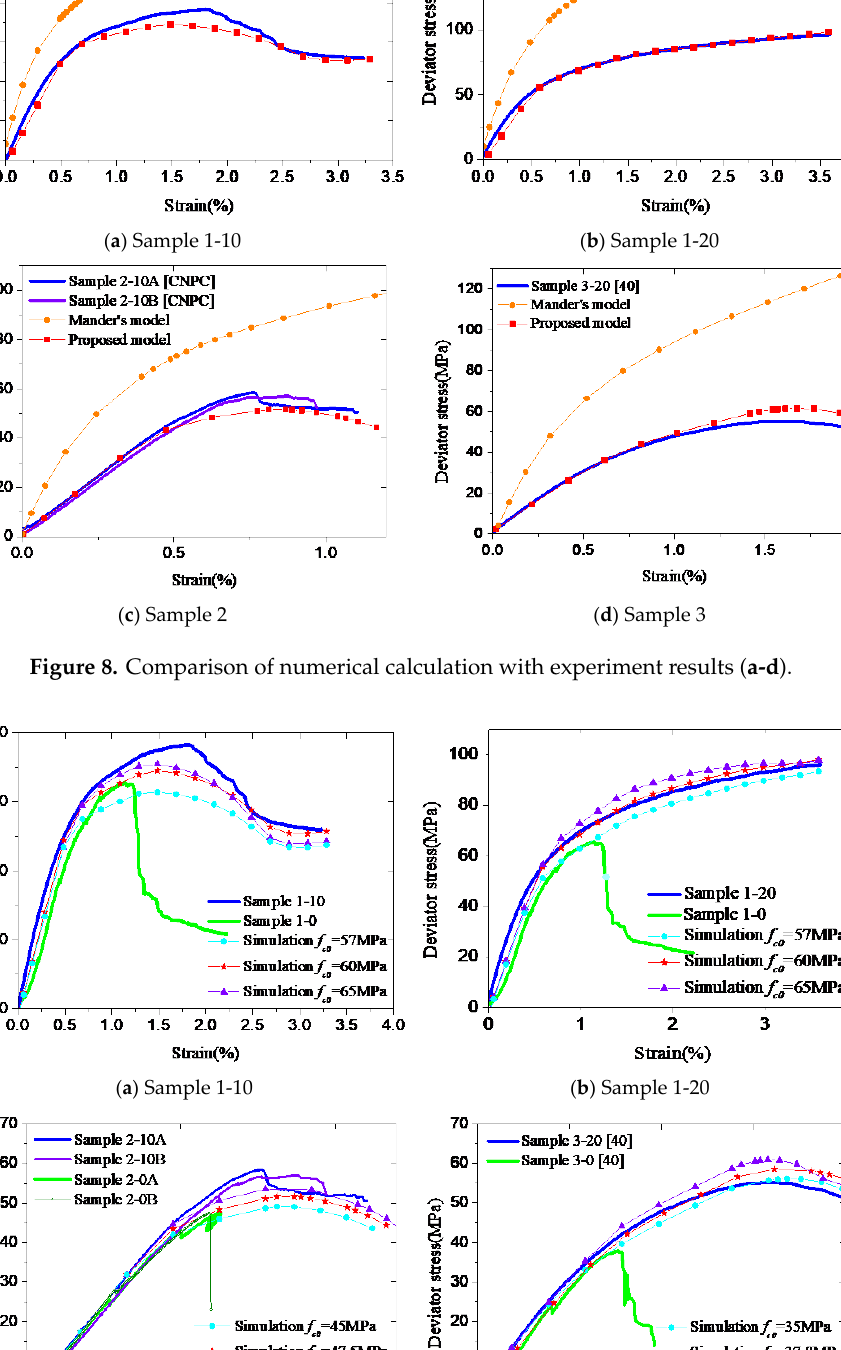
Figure 7. Stress–strain models of samples.